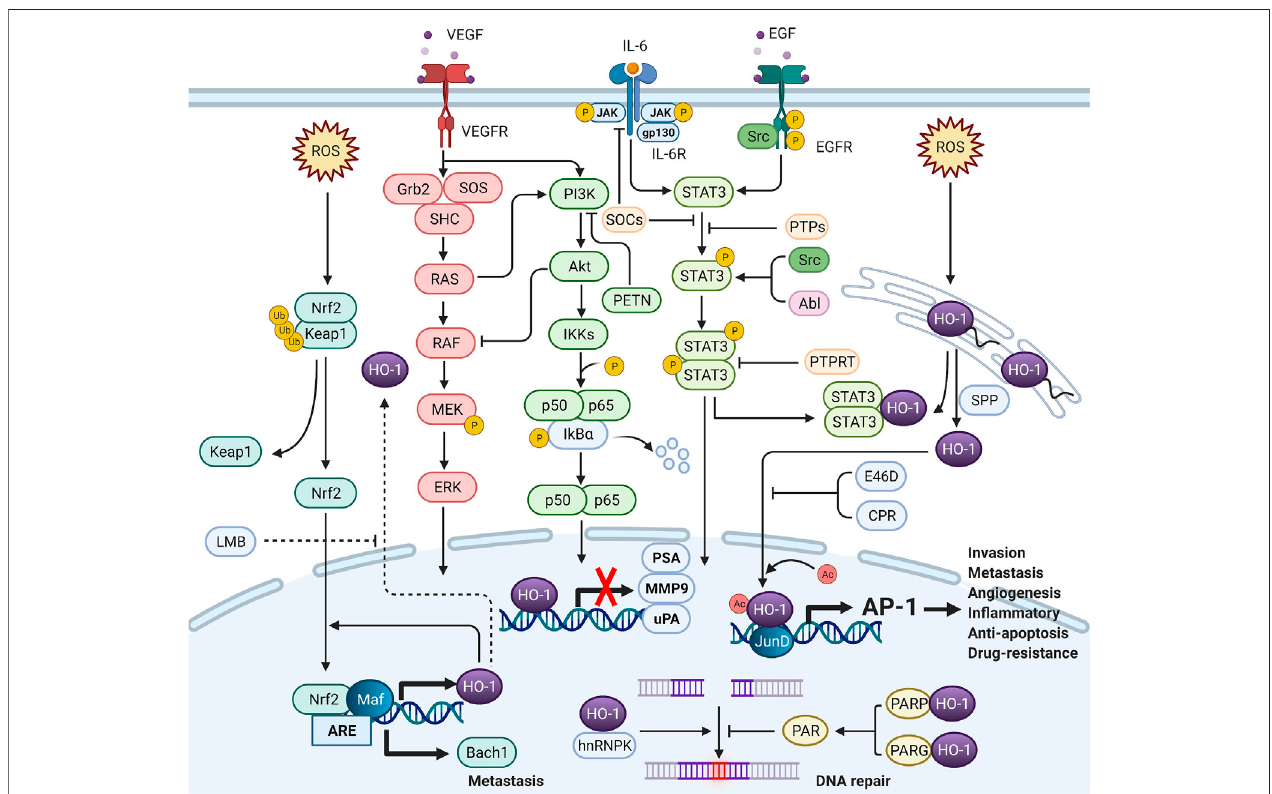
FIGURE2| ThecrosstalkbetweennuclearHO-1andsignalingpathways(CreatedwithBioRender.com.).Inthenucleus,HO-1interactswithotherproteinstoalter transcriptionandtranslation.HO-1completelybindstoNF- κ BandSTAT3,thusreducingtheactivityofthePSA,MMP9anduPApromotersandmRNAlevels.HO-1also binds toJunD to activate AP-1, increasing tumor aggressiveness. Heterogeneousnuclear ribonucleoprotein K (hnRNPK) has the effect of inhibiting protein translation in the cytoplasm. When hnRNPK and HO-1 migratetothenucleustogether, DNArepair canbeinitiated. When HO-1 bindsto PARP, DNA repair can beblocked. HO-1 reacts with Nrf-2 to enhance Bach-1 production, thus promoting